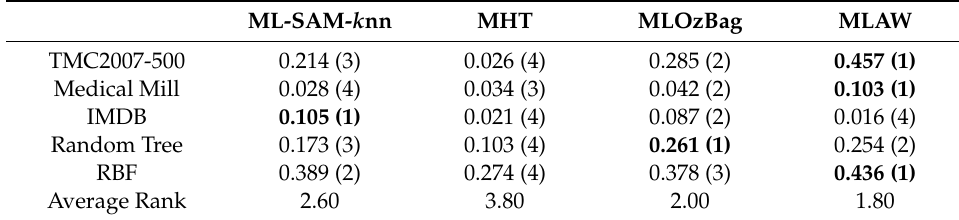
Table 7. F 1 of di ff erent